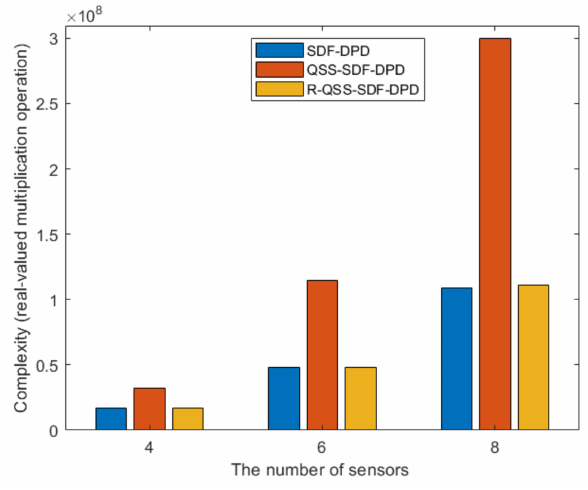
Figure 4. Comparison of